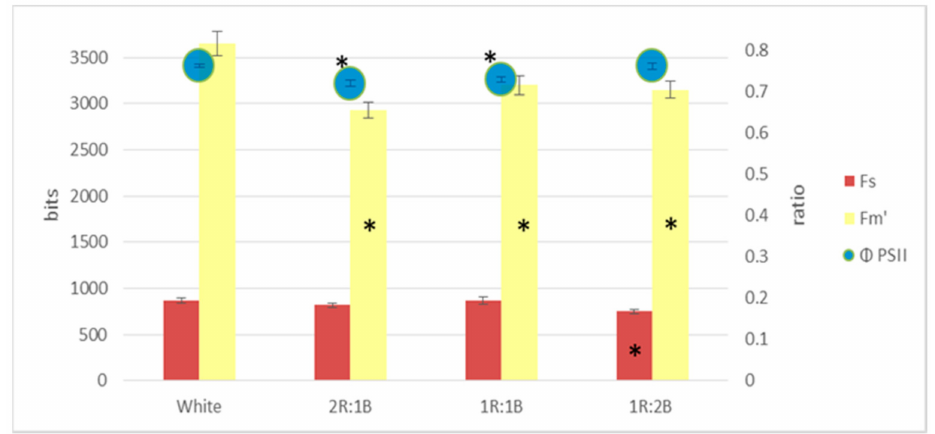
Figure 2. Chlorophyll fluorescence parameters in green basil cultivar (* represents significant differences from white light treatment for p < 0.05).